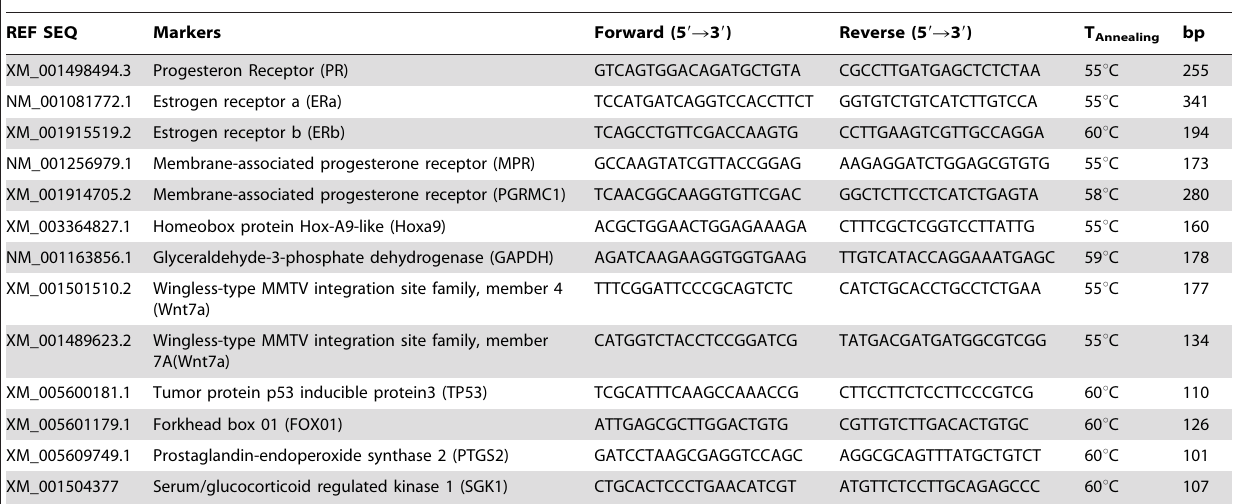
Table 1. Oligonucleotide sequences used for RT-PCR analysis.